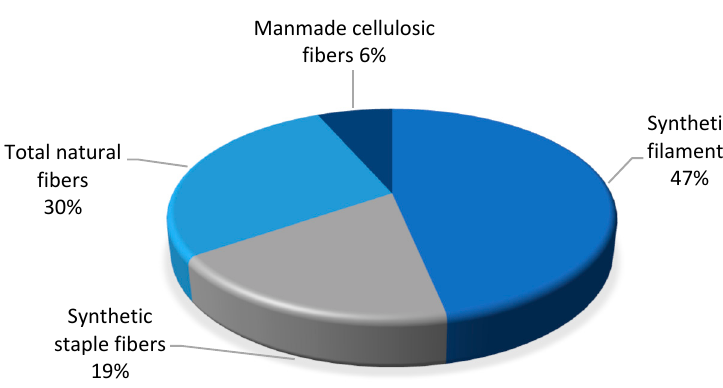
Figure 20. World production of all textile fibres in 2019 based on [115].